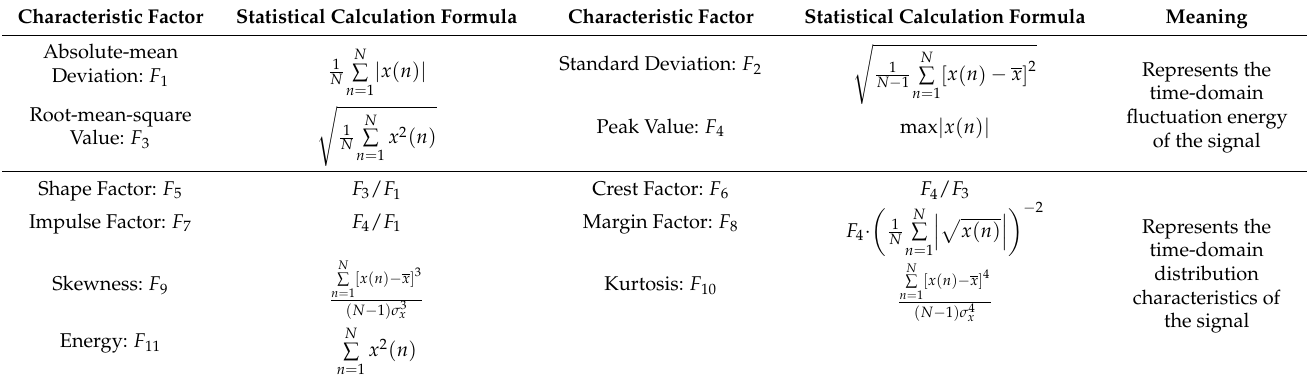
Table 4. Meanings and statistical calculation formulas of selected characteristic factors.